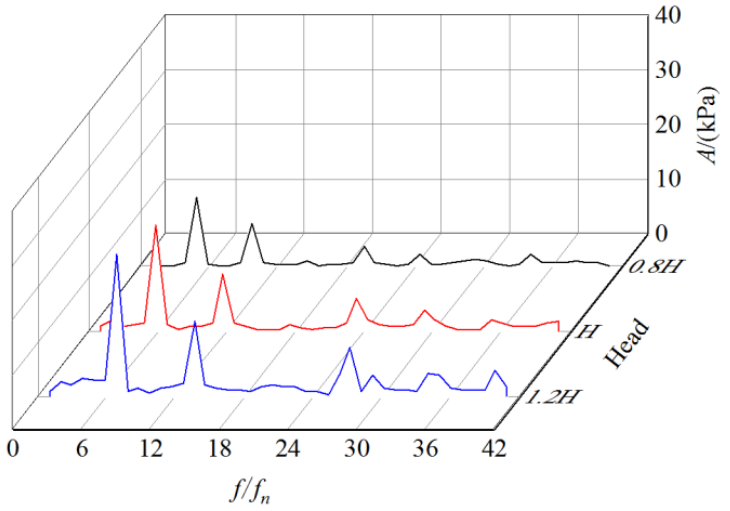
Figure 18. Frequency domain of pressure fluctuation at various head in volute (curves 0.8 H , H and 1.2 H represent frequency domain curves when the head is 0.8 H , H and 1.2 H respectively).